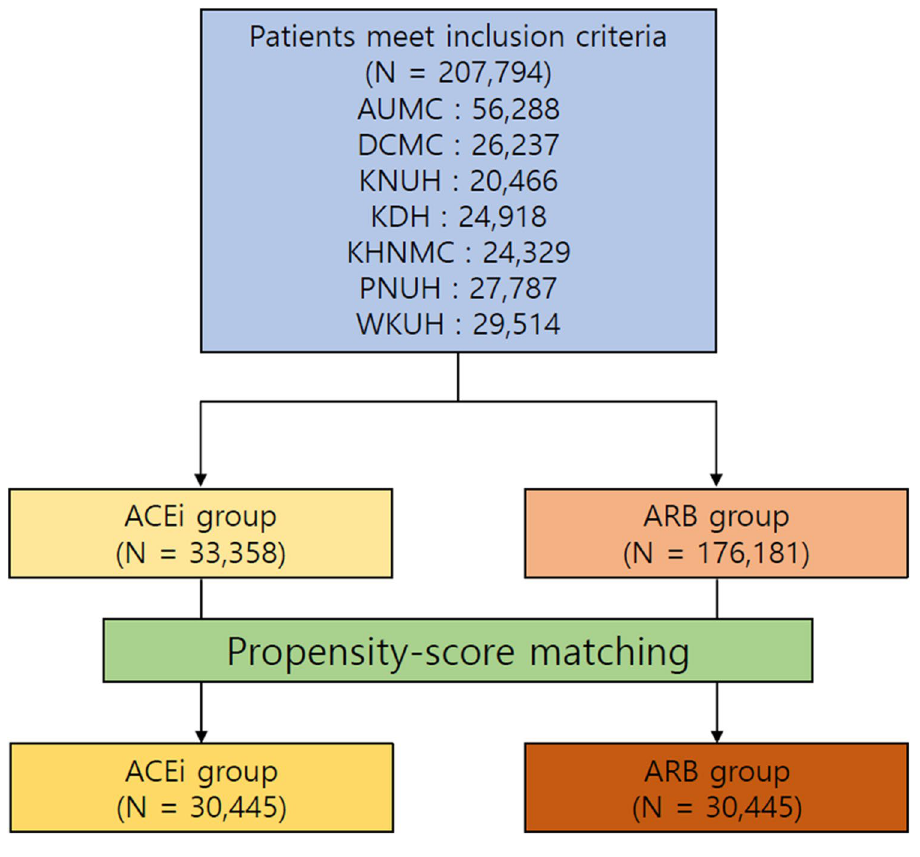
Figure 1. Flowchart of the